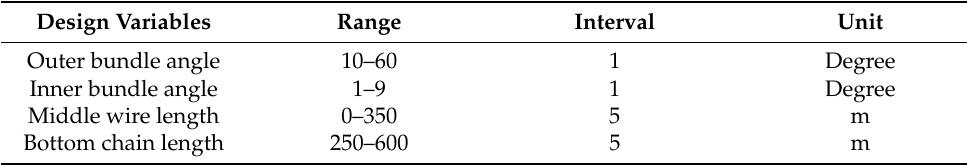
Table 6. Design variables for the mooring system